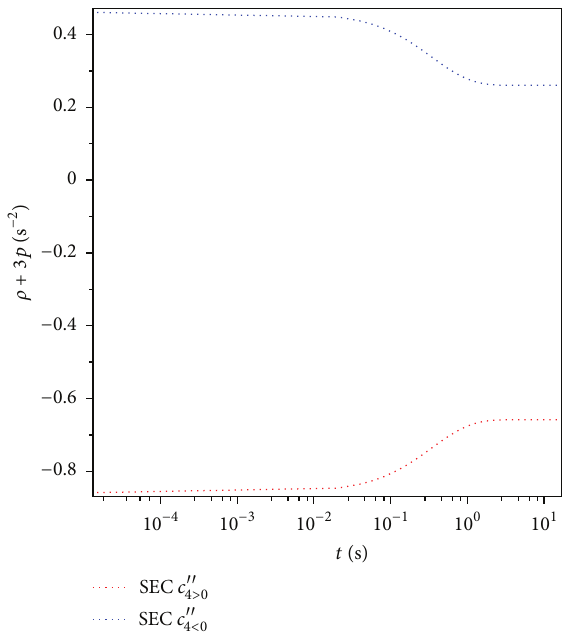
Figure 6: The evolution of SEC for open model. Here the sign of the three constants 𝑐 󸀠 1 , 𝑐 󸀠 2 , and 𝑐 󸀠 3 has no effect on the evolution of SEC; however, 𝑐 󸀠 4 must have negative value to satisfy the